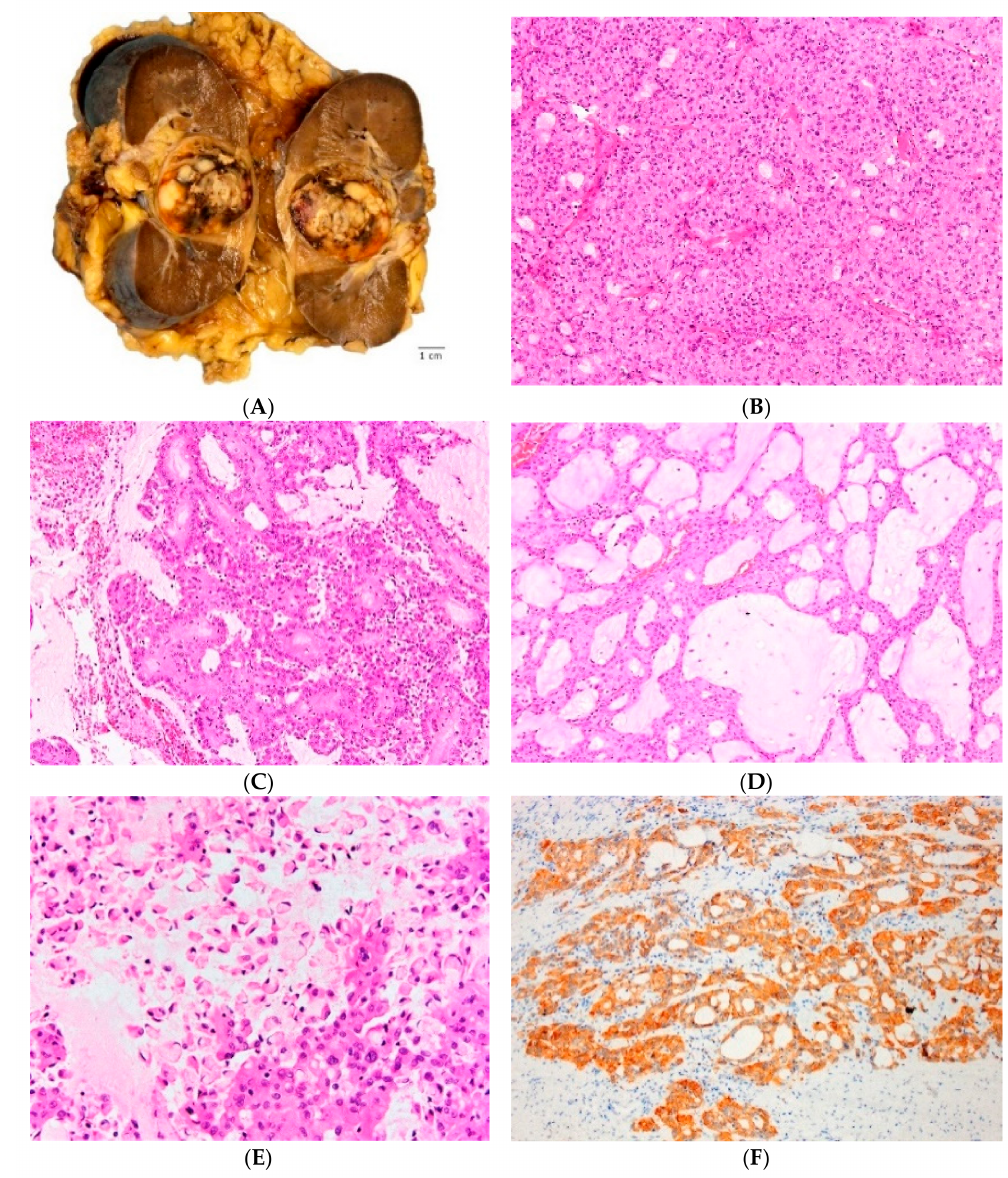
Figure 2. ALK rearrangement-associated RCC (ALK-RCC) shows a variegated gross appearance ( A ). On microscopy, multiple growth patterns can be seen in a single tumor, including solid ( B ), papillary ( C ), tubular and tubulocystic ( D ). Intracytoplasmic vacuoles and individual signet ring cells can also be found ( E ) often with a mucinous background ( D , E ). There is ALK1 protein expression